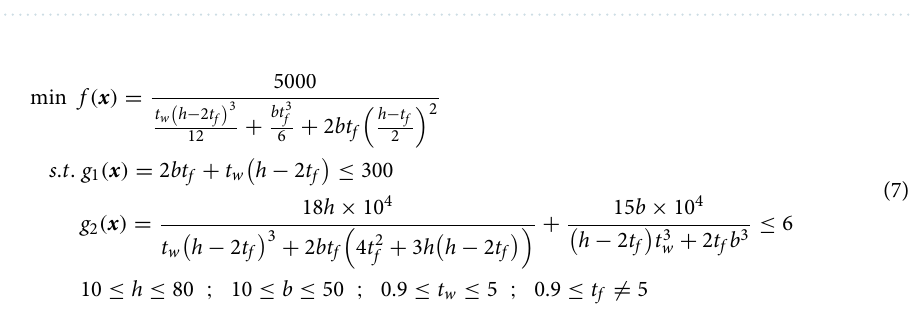
Table 3. Comparison results of selected algorithms for classical benchmark problem. Significant values are in